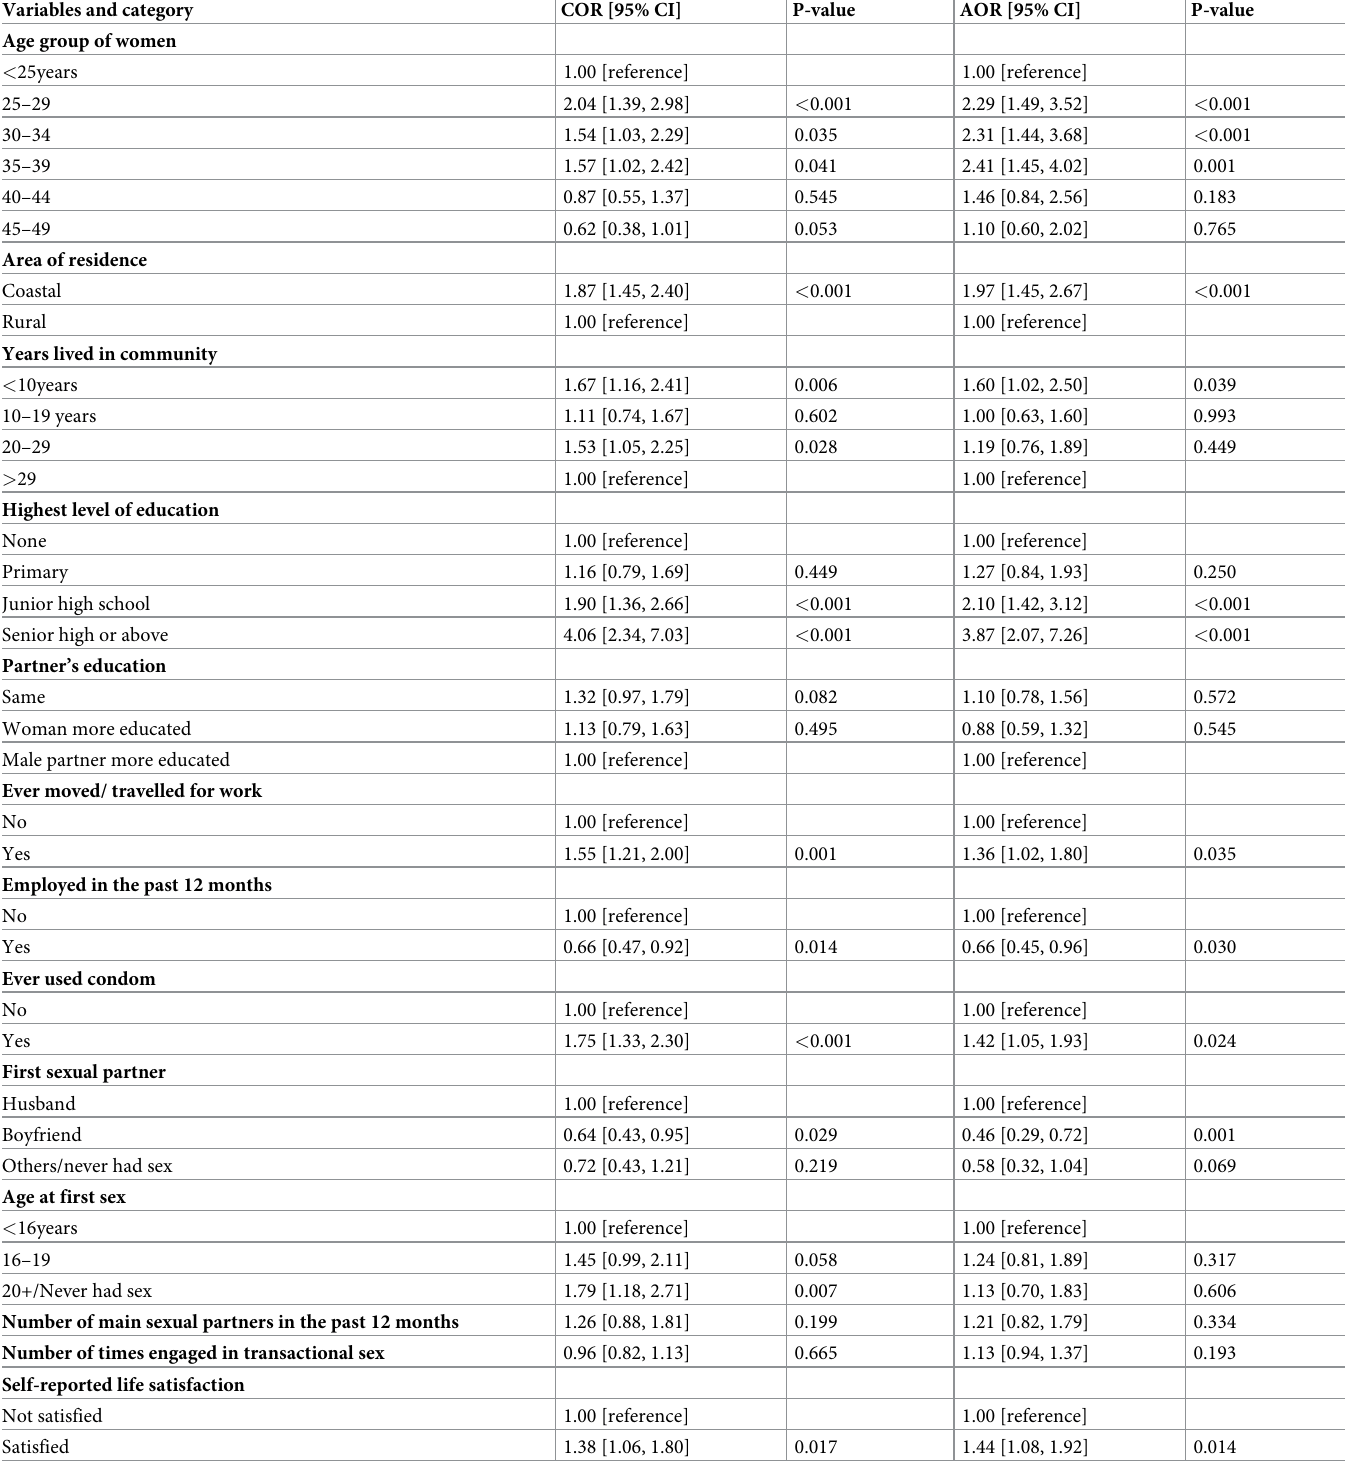
Table 3. Logistic regression model of predictors of HIV testing among